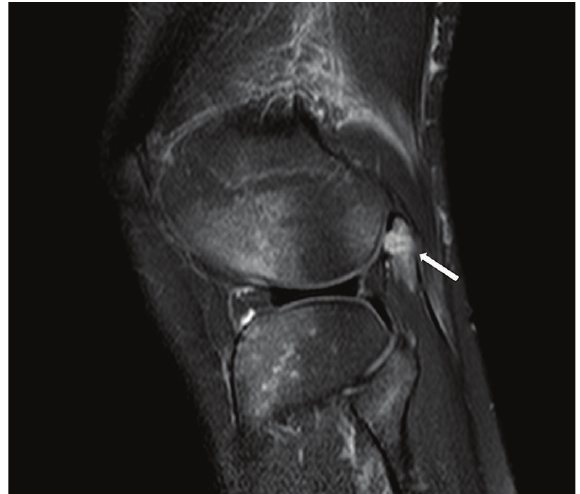
Figure 2: A sagittal T2-weighted fat-suppressed MRI demonstrated di ff use bone marrow edema pattern of the fabella (white arrow) associated with fracture seen on radiographs.